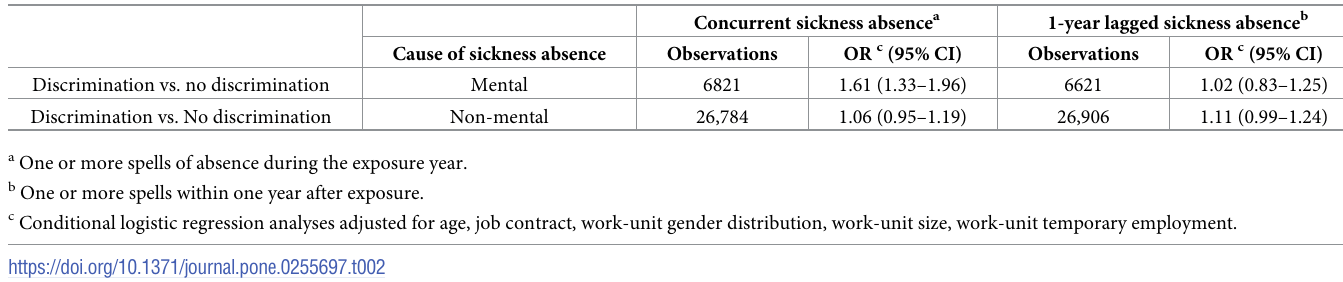
Table 2. Changes in workplace discrimination for concurrent and 1-year lagged long-term sickness